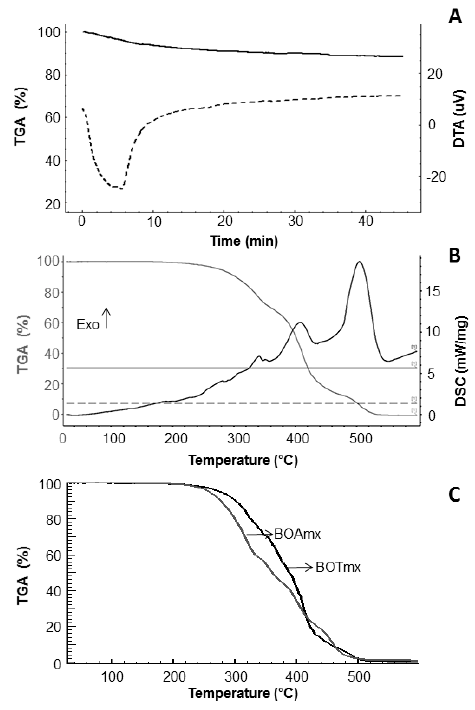
Figure 6. Thermal analysis of BO samples. ( A ) Thermogravimetric analysis—TGA ( — ) and differential thermal analysis—DTA ( --- ) curves of fatty tissue of the bullfrog by the isotherm method; ( B ) TGA ( — ) and differential scanning calorimetry—DSC ( — ) curves of bullfrog oil without antioxidants; ( C ) TGA curve of bullfrog oil containing antioxidants at the maximum concentration BOTmx ( — ) and BOAmx ( — ).